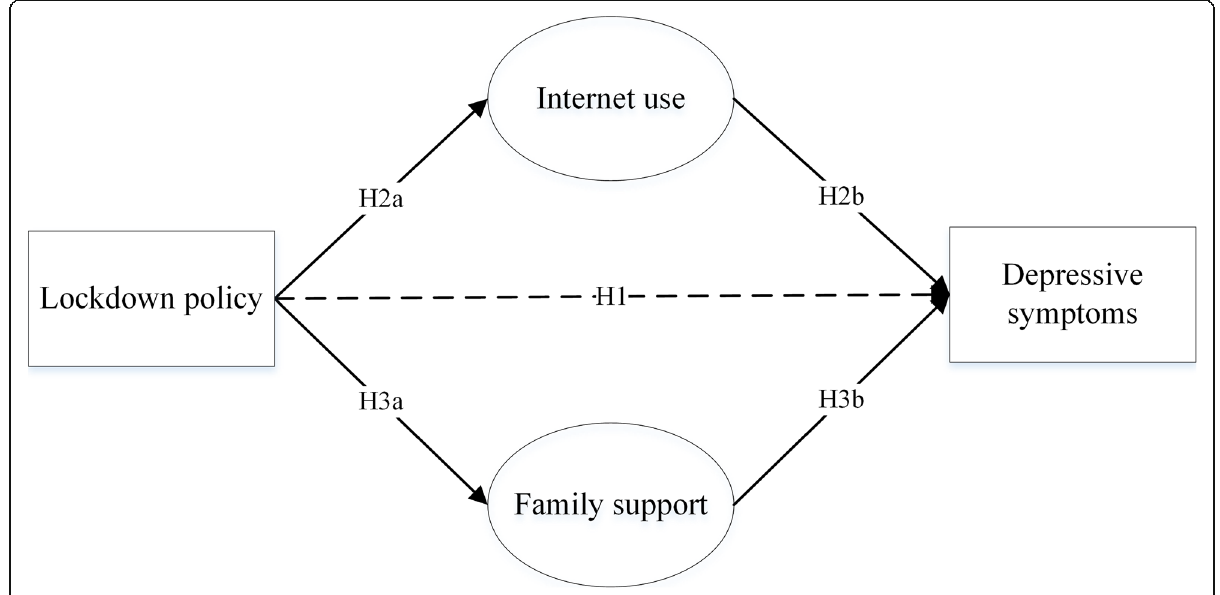
Fig. 1 Research model and hypothesized